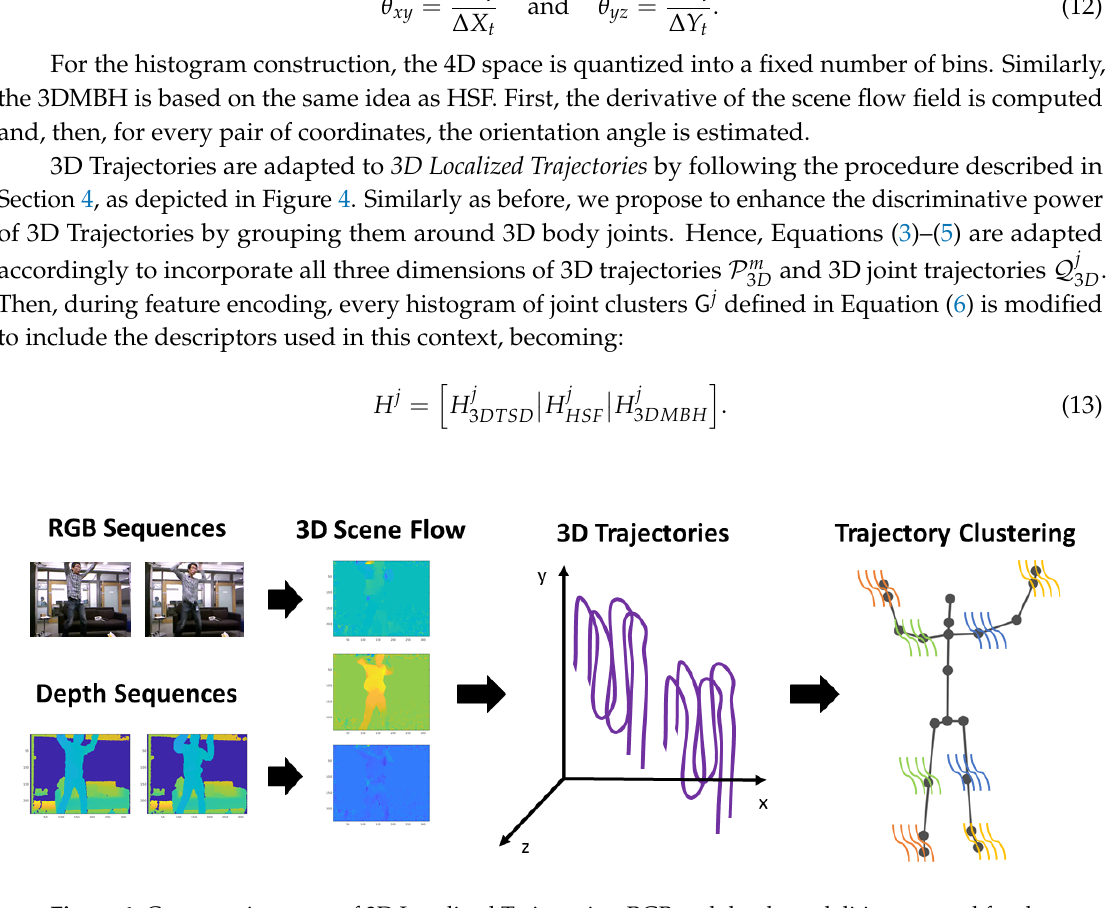
Figure 4. Computation steps of 3D Localized Trajectories. RGB and depth modalities are used for the estimation of the scene flow constituted of three components. Then, using the estimated scene flow, 3D Trajectories are generated. Finally, the latter are clustered around 3D body joints. A different color has been used for each